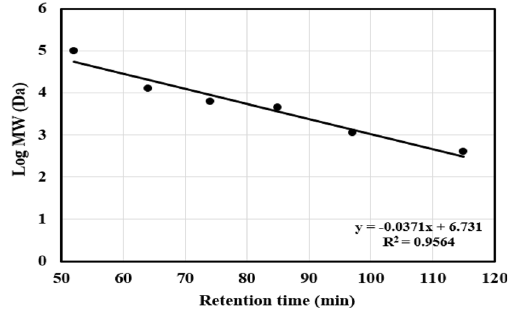
Fig. 1 PEG calibration curve for molecular weight distribution